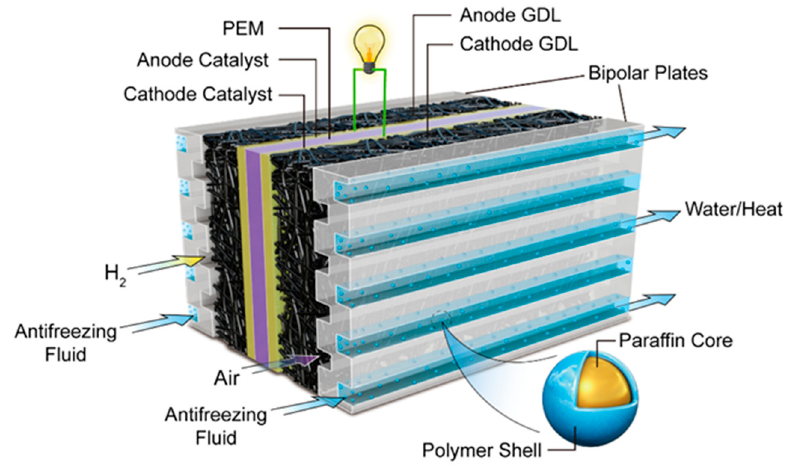
Figure 1. The mechanism diagram of phase change microcapsules for PEMFC cold start.